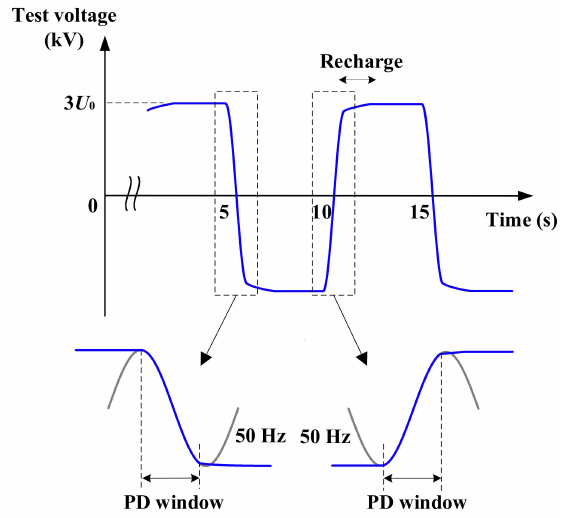
Figure 4. VLF cosine-rectangular voltage